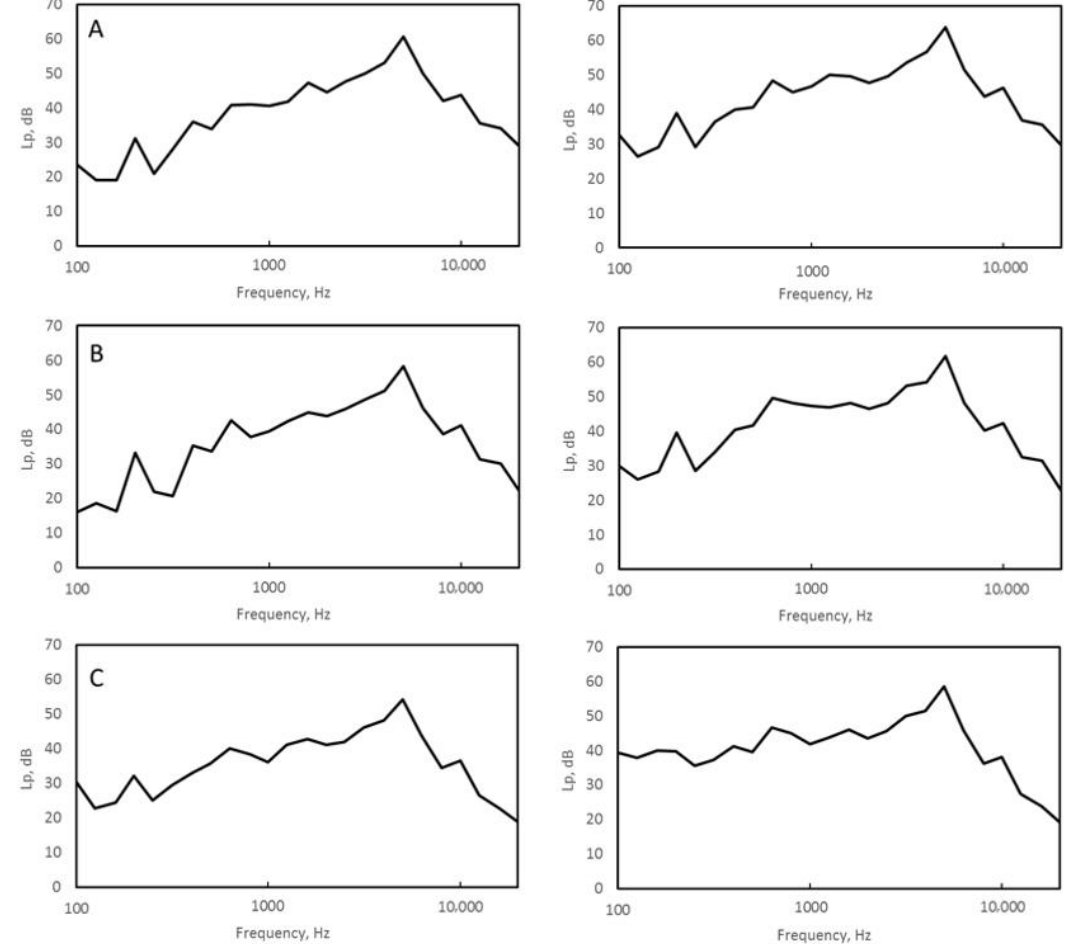
Figure 6. Values of the minimum (at the left) and average (at the right) spectrum emitted in the position of the UAV in the environment under test, with anthropic noise (music). The receiver–source distances are respectively: (A equals 5 m, B equals 10 m, and C equals 15 m).